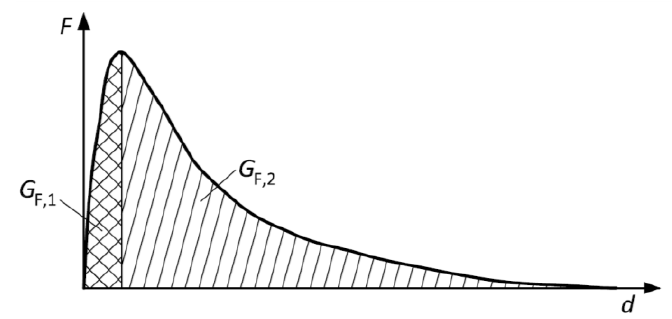
Figure 4. The considered parts of fracture energy.